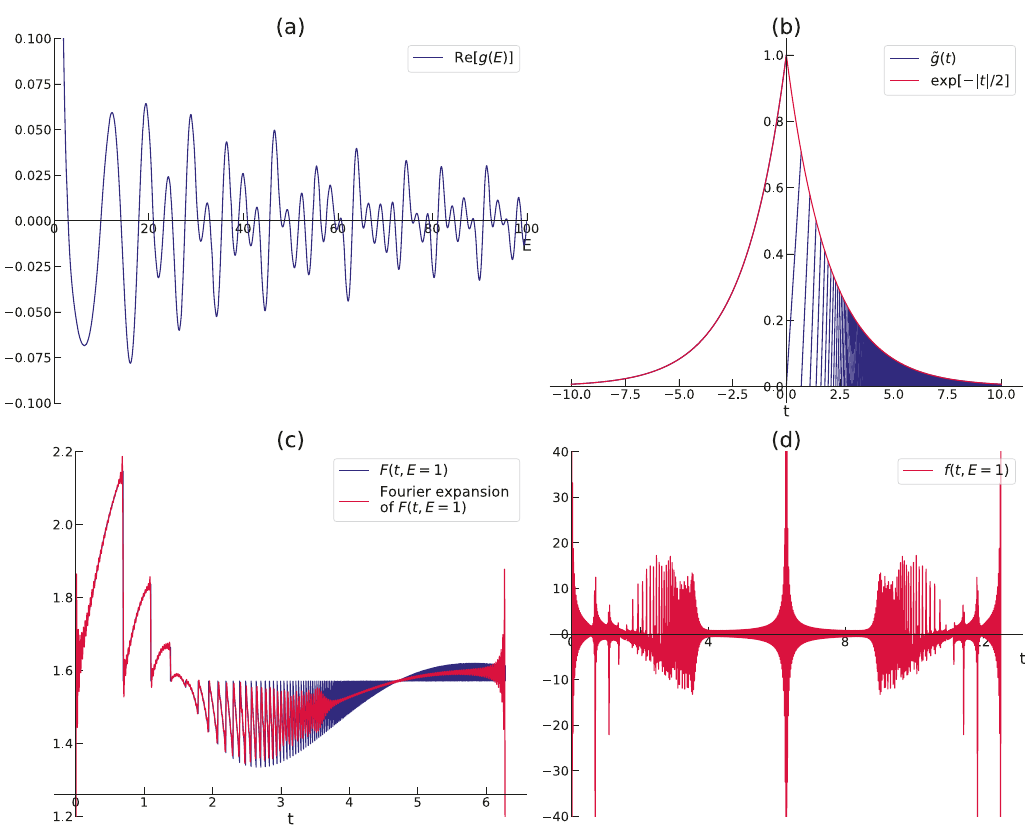
Fig. 4 Derivation of the driving function. a The real component of g ( E ) = − ζ (1/2 + iE )/(1/2 + iE ). b Van der Pol ’ s function is the Fourier transform, ~ g ð t Þ , of g ( E ). The function is bounded by the red curve exp (cid:2)j t j = 2 ½ (cid:3) , and contains an in fi nite number of fi nite discontinuities for positive t , arising from the fl oor function (see Eq. (4)). c The blue curve shows F ð t Þ ¼ cos (cid:2) 1 ~ g ð t Þ cos Et ð Þ , the primitive of the driving function, for driving parameter E = 1. The discontinuities in ~ g ð t Þ give rise to discontinuities in this function as well. The red curve shows the